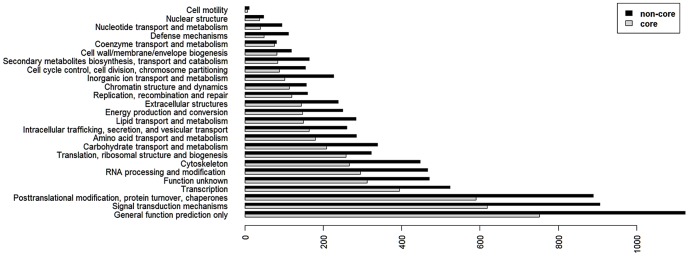
Distribution of KOG annotations and comparison of the core and non-core (variable) genome of (16 strains of) E. huxleyi.KOG annotations of the E. huxleyi genome strain CCMP1516 (JGI) were used to identify functional classes of the core and non-core genome.